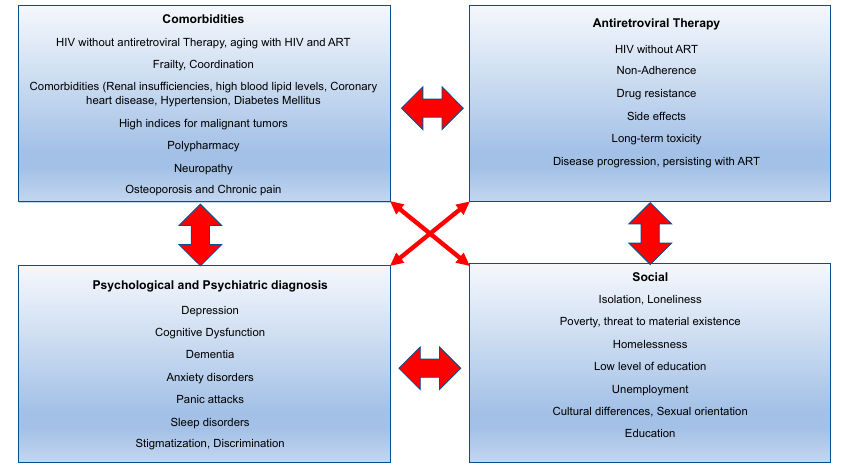
Figure 4. Categories of HIV complexity (own presentation) (Watson, 2018 [70]).